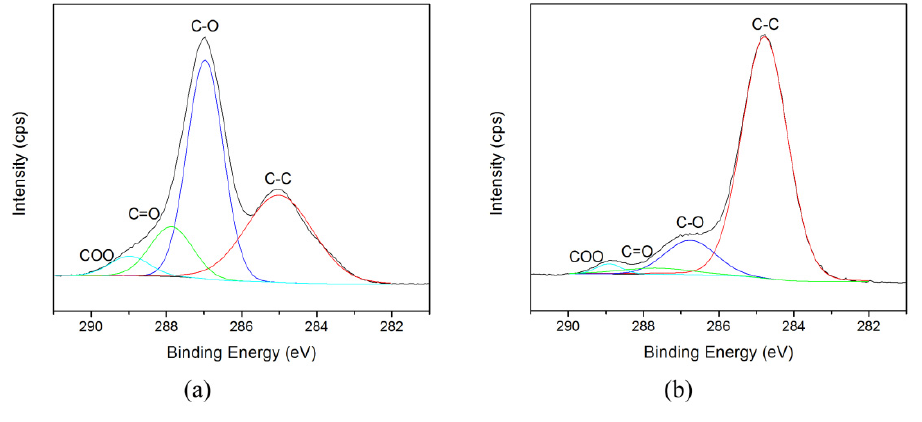
Figure 3. High-resolution XPS spectra of C1s for GO ( a ) and GO-DOPO-V ( b ).